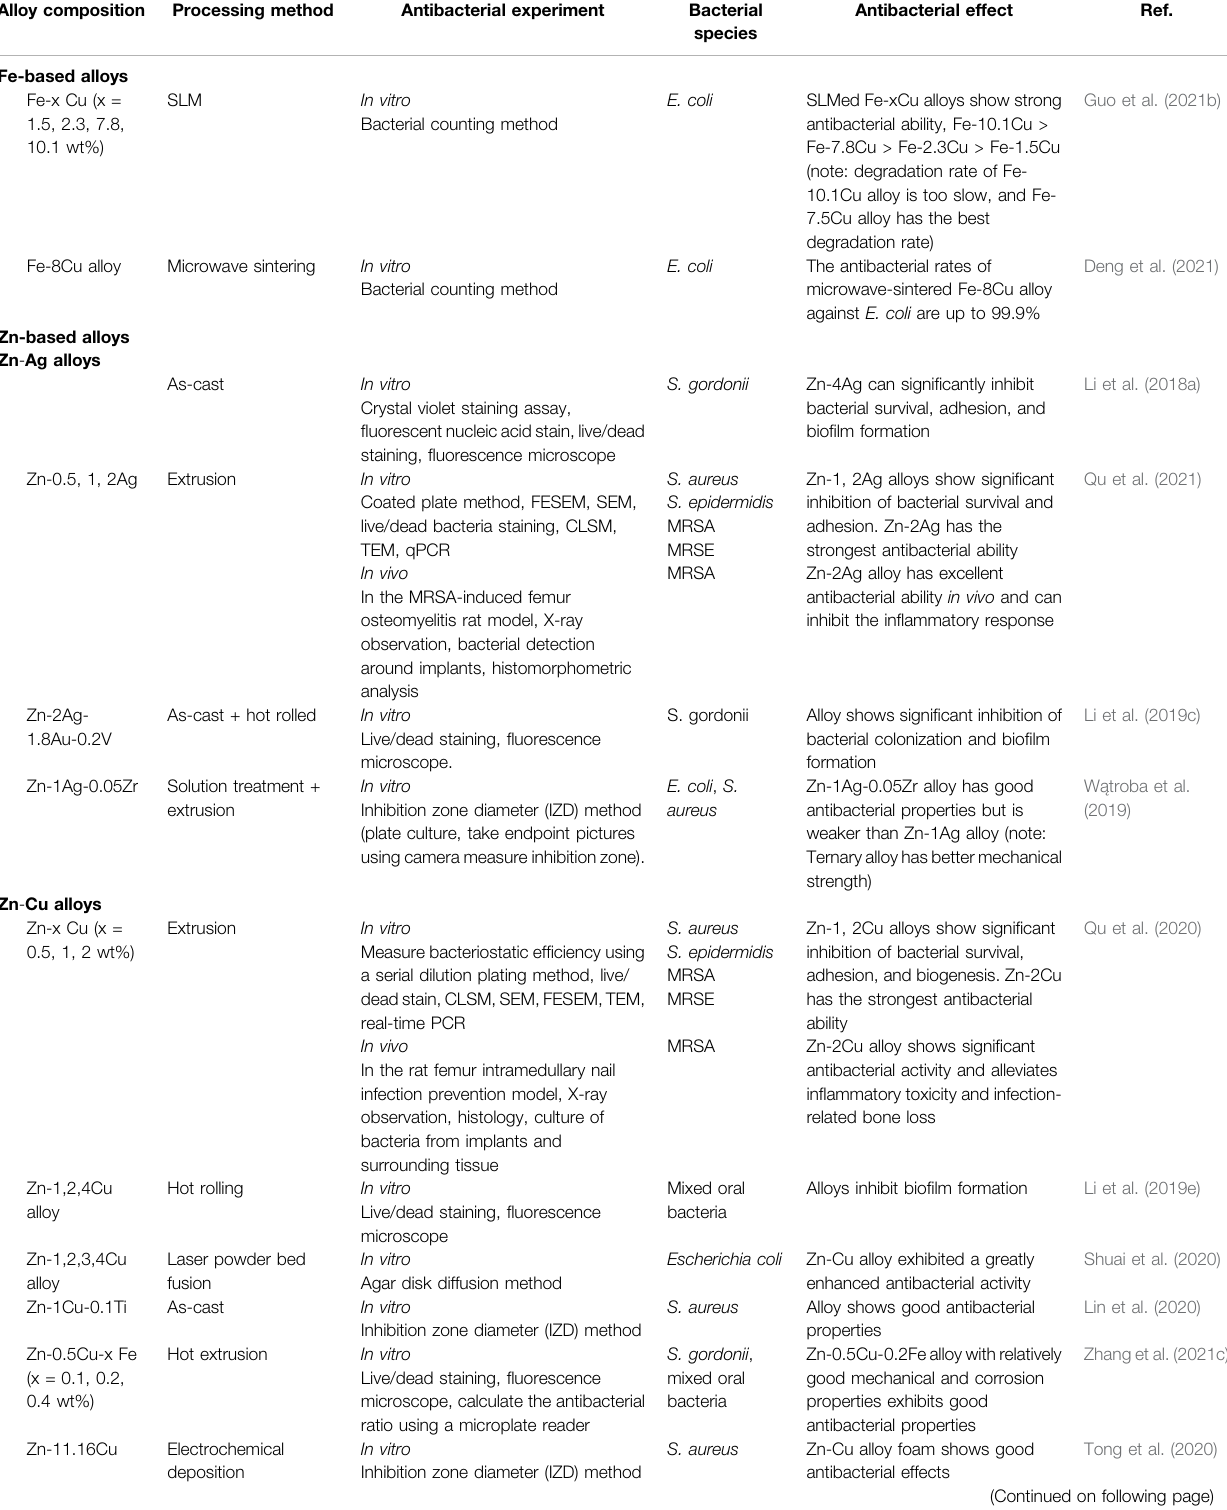
TABLE 6 | Antibacterial properties of Fe- and Zn-based alloys with antibacterial properties as orthopedic implants. Alloy